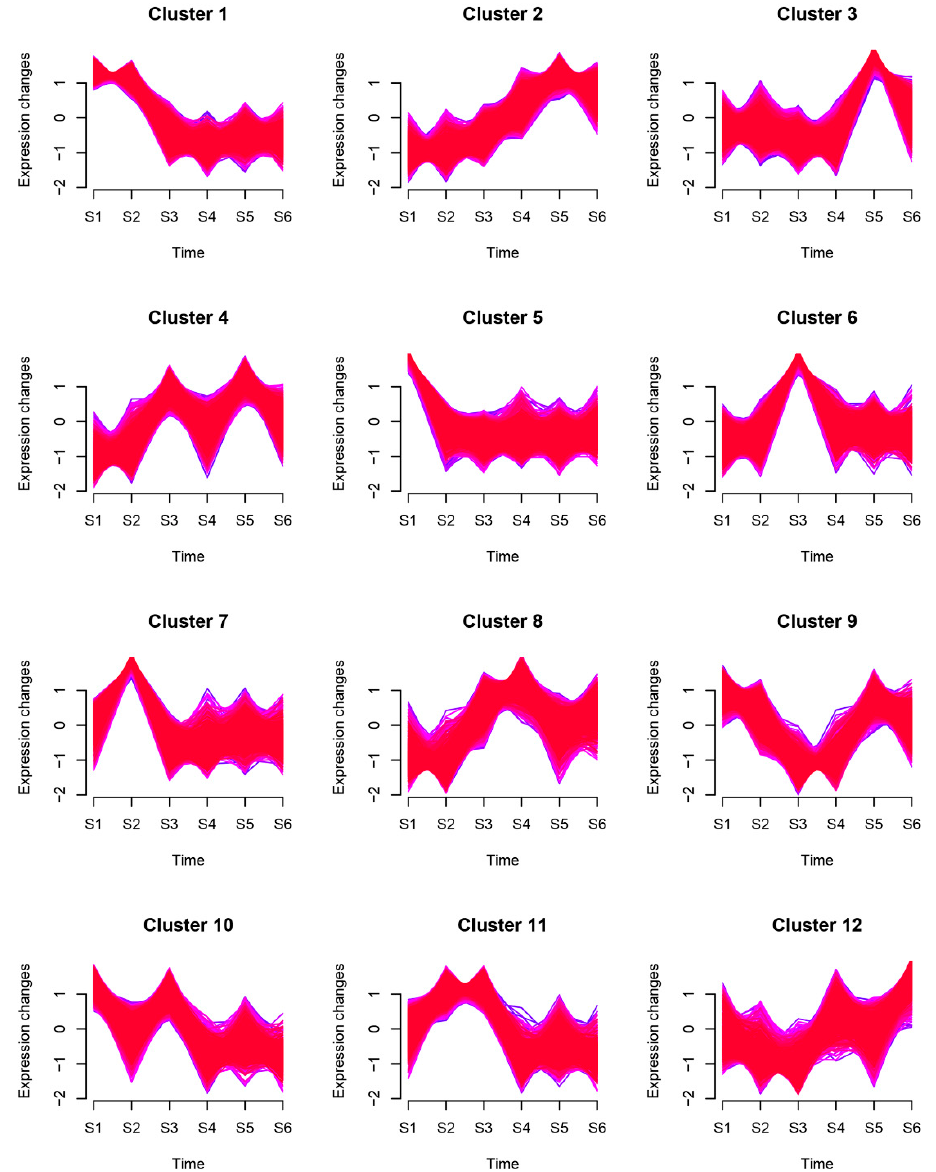
Figure 2. Time-associated gene clusters. According to the gene expression information, genes with similar expression patterns at different time points were clustered into different groups.